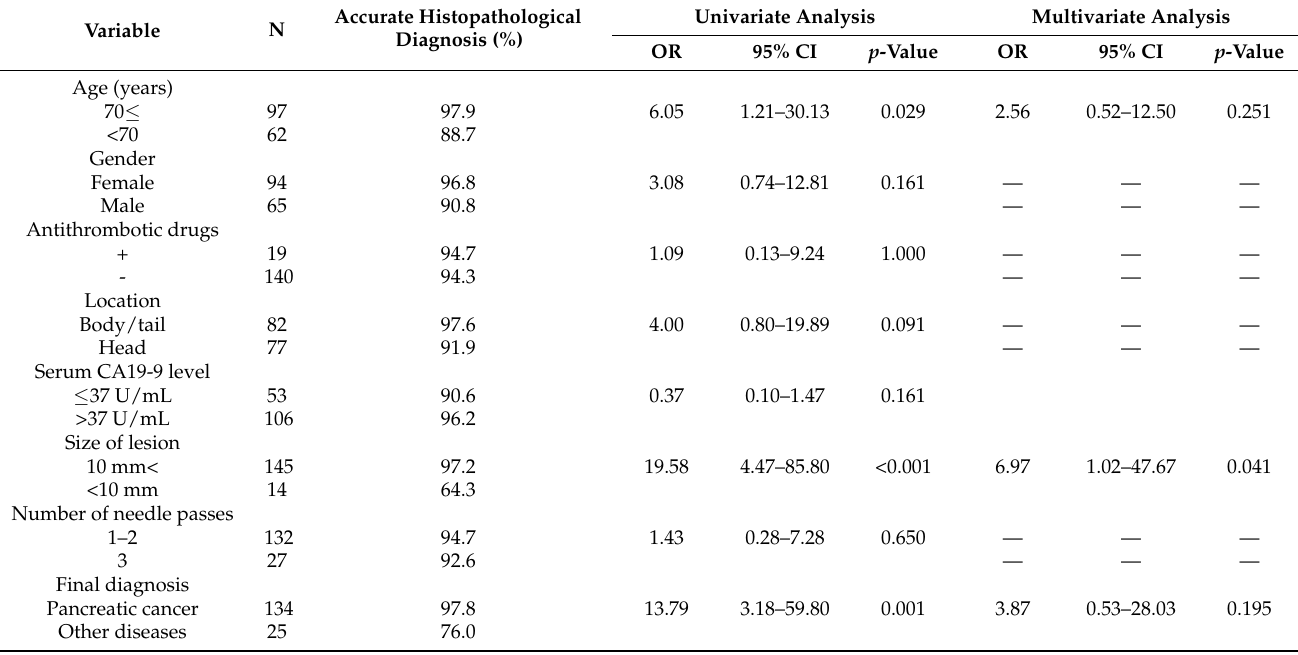
Table 6. Univariate and multivariate analyses of factors influencing the accurate histopathological diagnosis of EUS-FNB. Variable